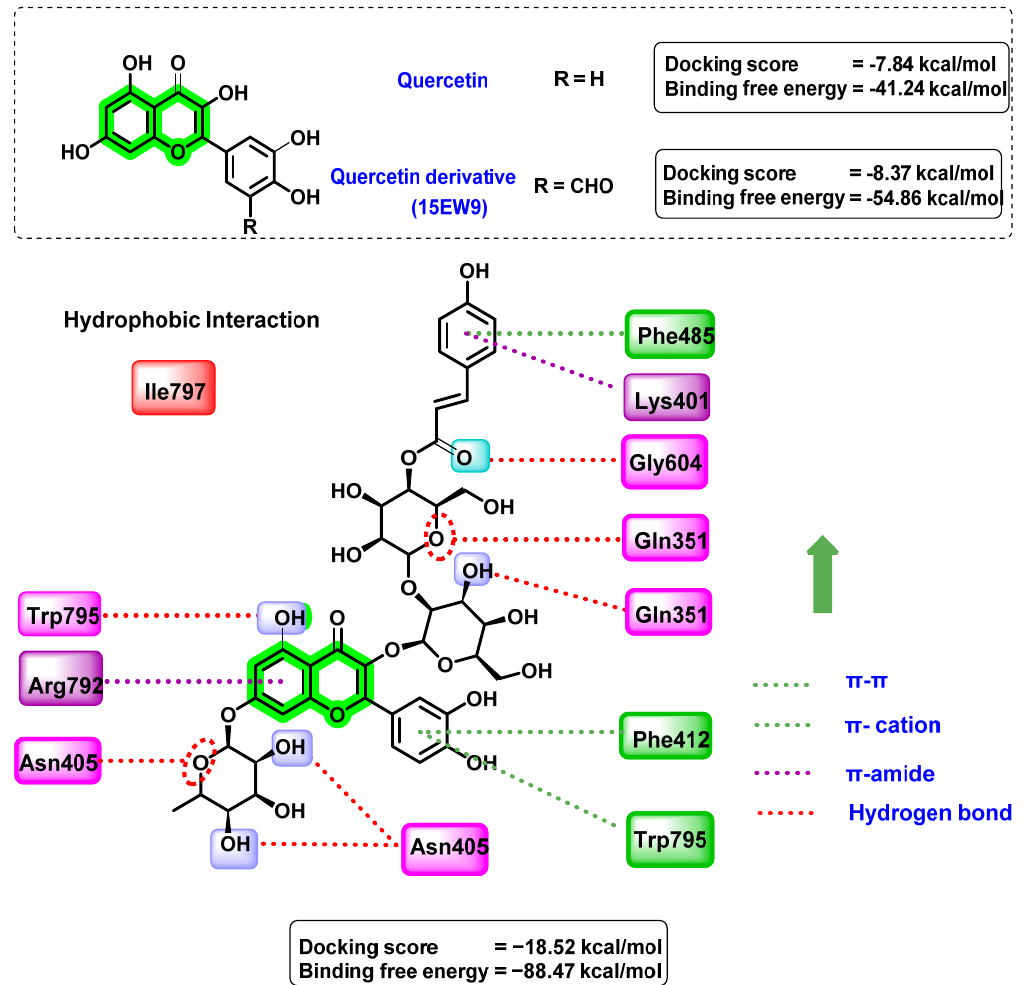
Figure 13. Docking interactions of quercetin and its derivatives with DENV NS5 RdRp.